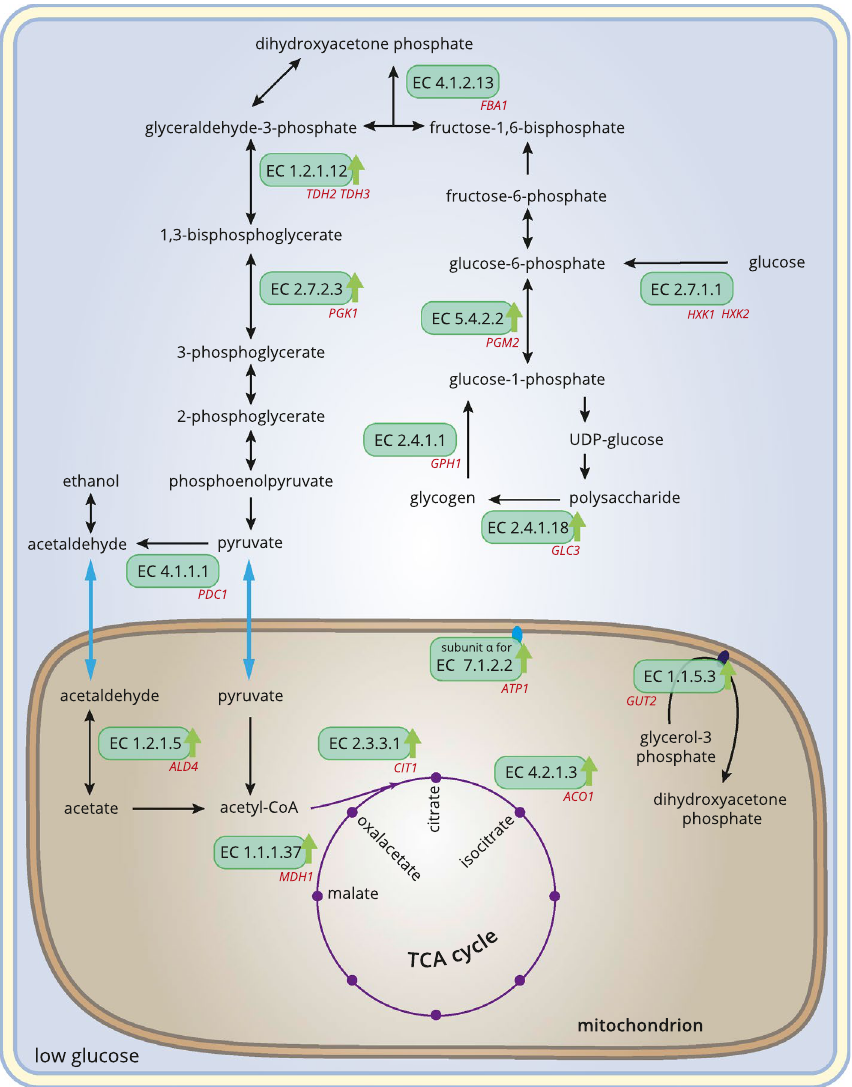
Figure 7. Functional role of glucose-concentration-dependent proteins in carbohydrate metabolism, TCA cycle and respiration. Reactions involving identified glucose-concentration-dependent proteins are represented by their EC numbers. The captions in red name the corresponding genes for the glucose-concentration-dependent proteins identified in the present study. Green arrows indicate likely upregulation at low glucose conditions. Transport processes are indicated by blue arrows, chemical reactions by black ones. For the latter, only a selection of reactants and products is